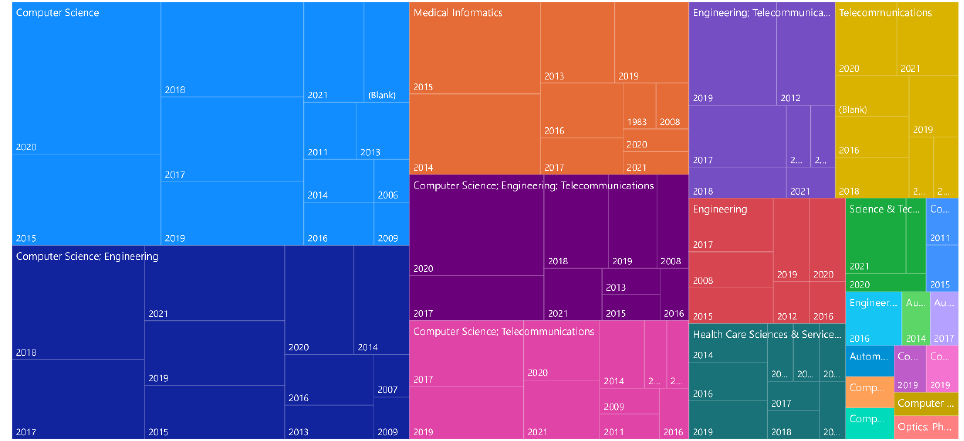
We then collected data from the relevant publications to conduct our analysis. We